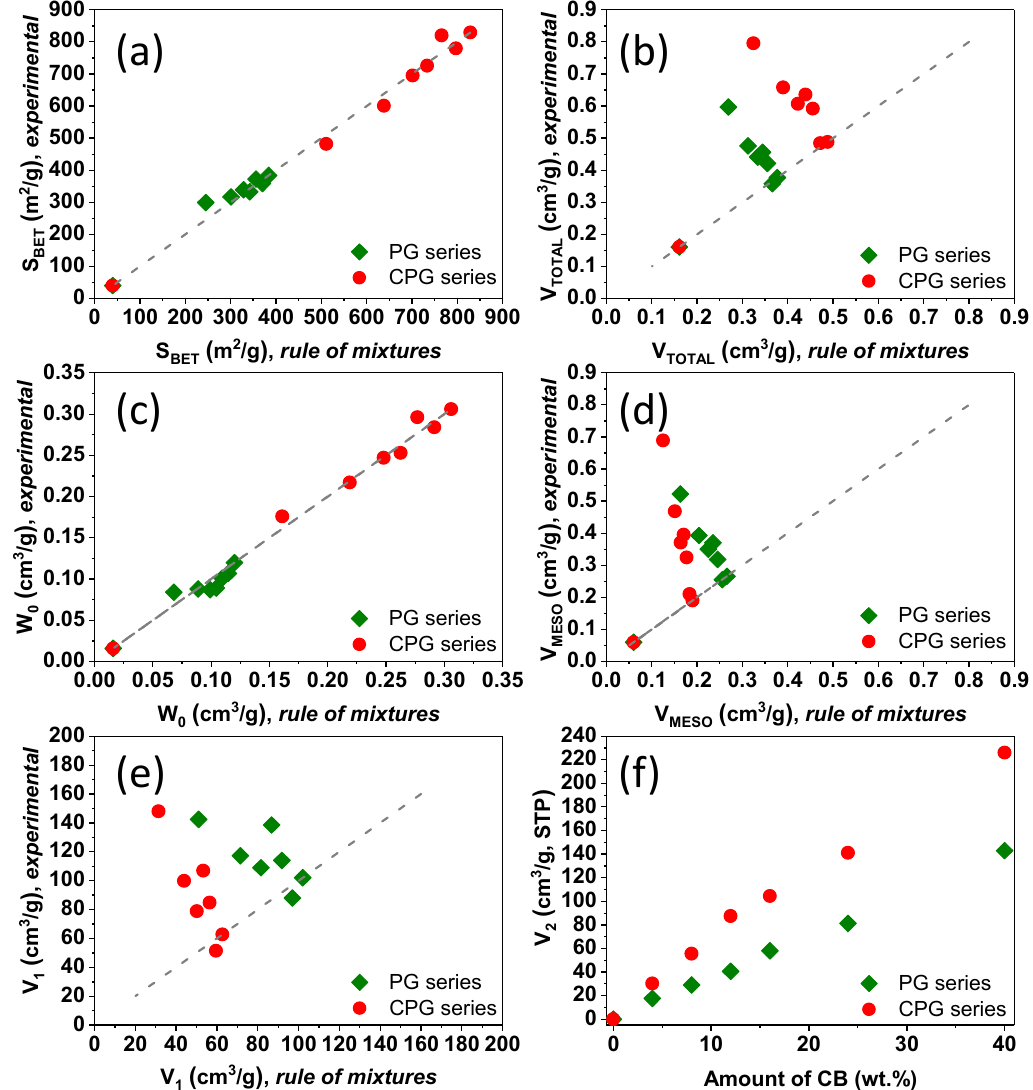
Figure 4. ( a – e ) Correlation of selected experimental textural parameters (surface area, pore volumes) of the gels / CB composites with the values predicted by the general mixing rule. Dashed lines indicate the expected trend following predictions of the general mixing rule. ( f ) Evolution of V2 with the amount of carbon